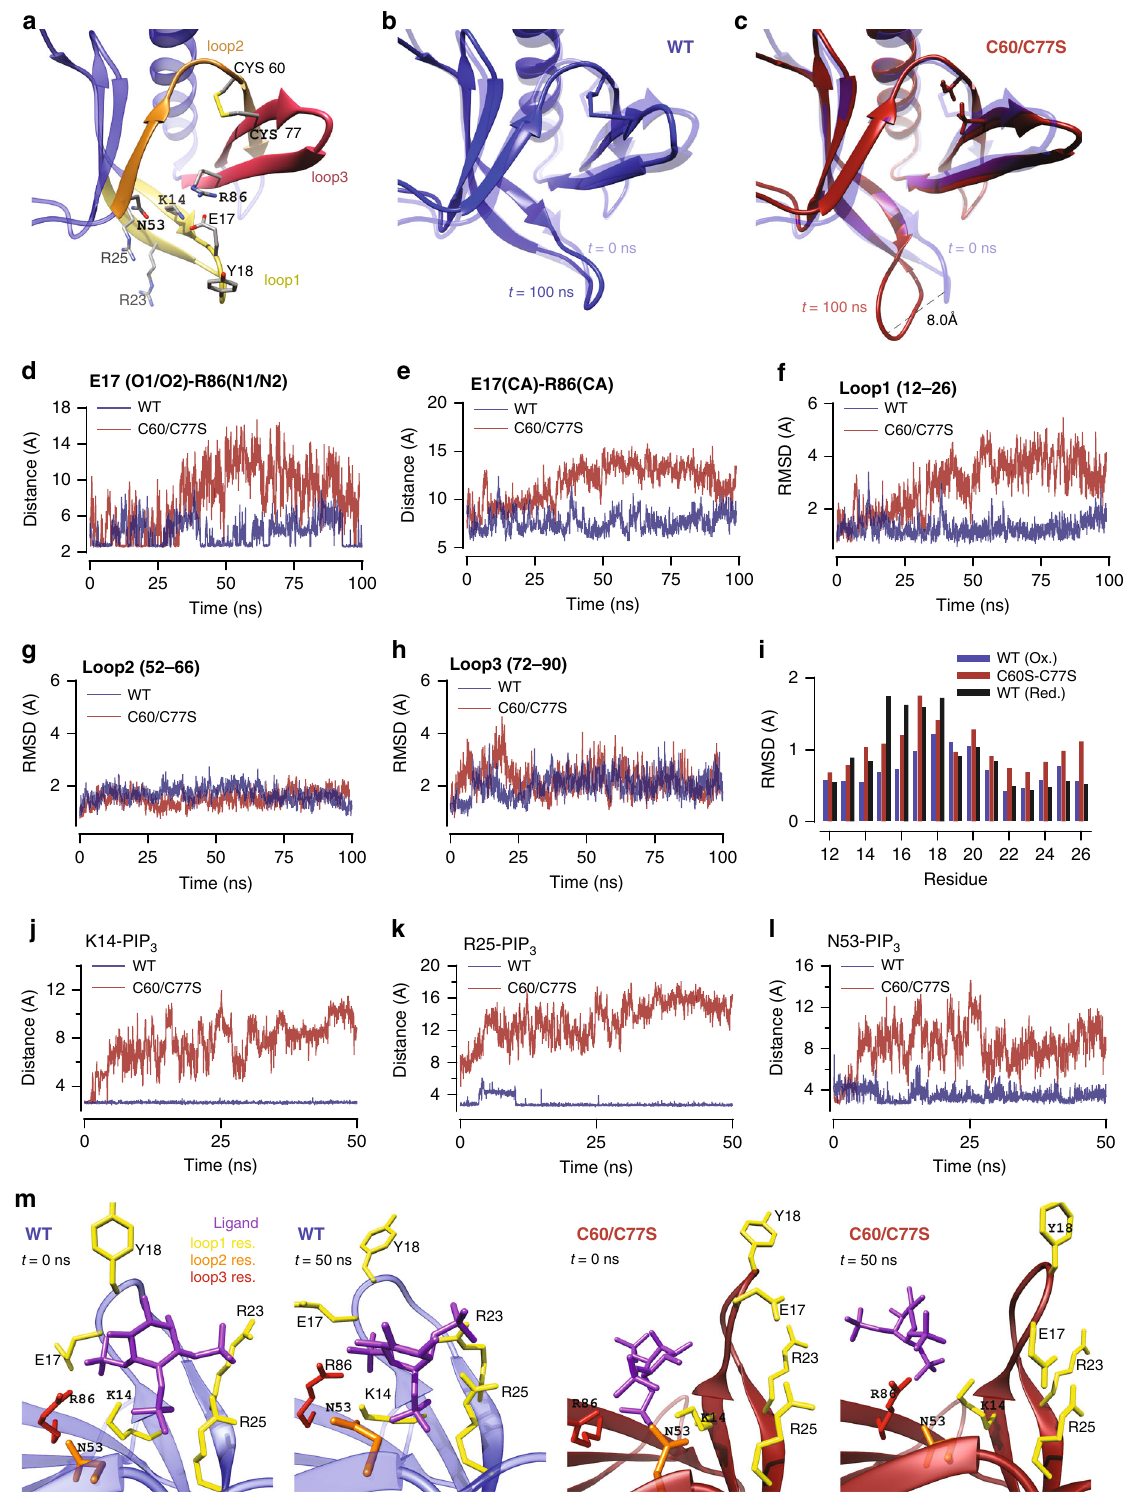
Fig. 5 MD simulations predict the C60-C77 disul fi de in Akt increases PIP3 af fi nity. a Akt1 PH domain (1unp) showing the disul fi de bond between C60 and C77, the key residues required for PIP3 binding and loops 1 to 3. b Comparison of the Akt1 crystal structure 1unp (transparent) with the WT and c C60/C77S structures obtained after ~100ns MD. d Time series of the E17(O)-R86(N) distance in WT and mutant Akt1. Only the distance between the closest O-N atoms are shown. e Time series of the Ca-Ca distances between the residues E17 in loop 1, and R86 in loop 3 in WT and mutant Akt1. f – h Comparison of the backbone RMSDs of the three loops in WT and mutant Akt1 calculated using the crystal structure as a reference. For loop 1, the RMSD is calculated for the residues 12 – 26, which are involved in binding of PIP3. i Residue speci fi c RMSDs of the loop 1 residues 12 – 26 for the WT and C60/77S and protonated C60/77 mutant Akts. j – l Time series of the contact distances involved in PIP3 binding to WT Akt (blue) and Akt-C60/77/S (red). j WT Akt K14(N Z ) – PIP3 (OPG/H) and